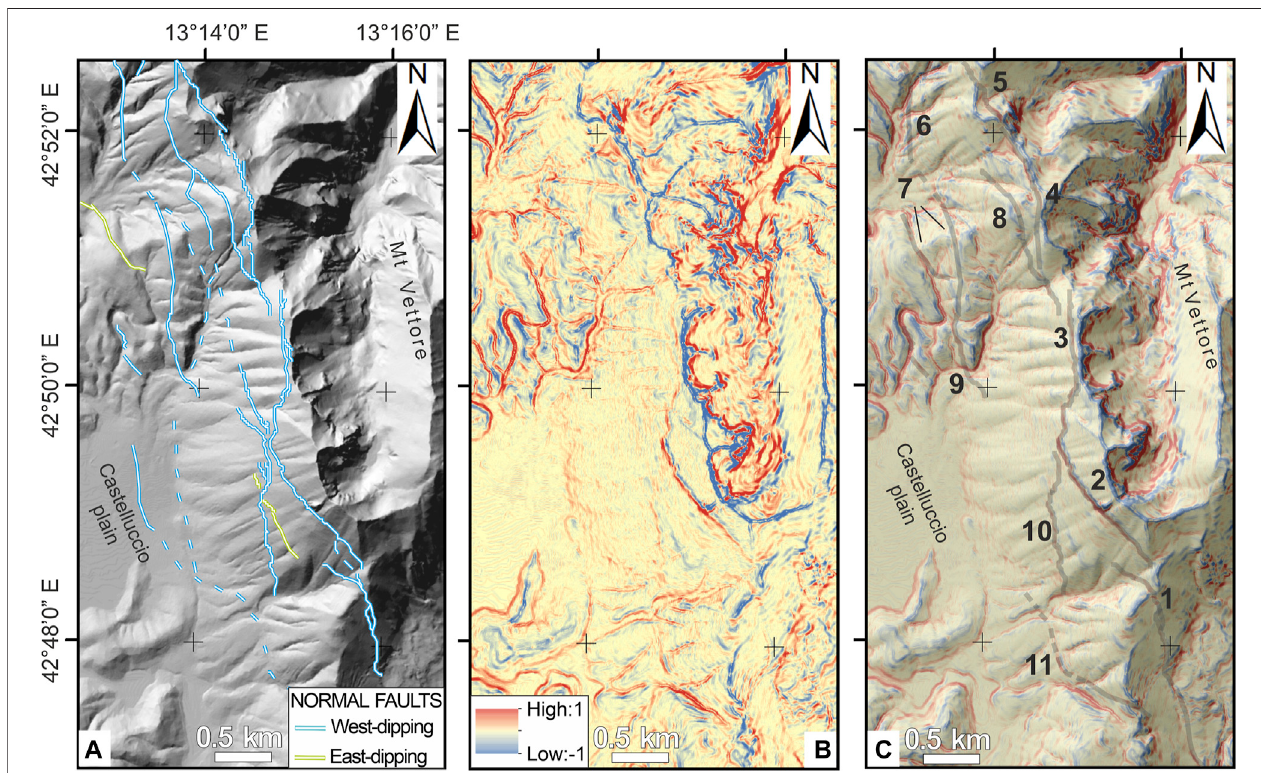
FIGURE 3 | Mt Vettore western slope (inset a in Figure 1B ) with topographic curvature analysis and comparison of results with the late-Quaternary active normal faults known for the sector. (A) hillshade from the 10 m-px resolution Digital Elevation Model of the area (Tarquini et al., 2007a) with superposition of the west- and east- dipping normal faults outcropping along the Mt Vettore western slope (from Brozzetti et al., 2019). Numbers refer to fault segments that match with the tectonic lineaments as inferred by the curvature analysis (panel (B) ) and reported in panel (C) . (B) Pro fi le curvature map (derivative computed parallel to the slope) with positive(red)andnegative(blue)valuescorrespondingtoconcaveandconvexfeaturesinthelandscape,respectively (C) matchbetweentheinferredtectoniclineaments from the curvature analysis (transparent light gray) and the fault segments reported in (A) . Numbers correspond to the points discussed in the